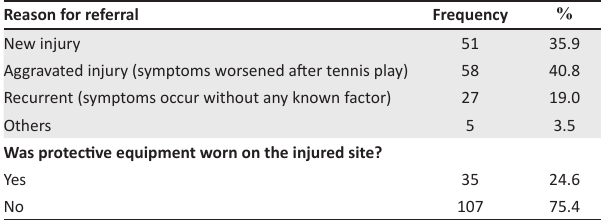
TAB LE 3: Reason for referral and use of protective equipment ( n = 142).